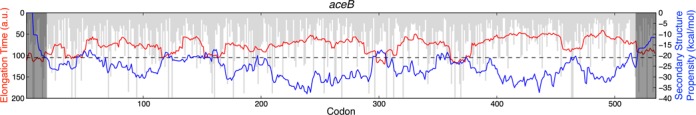
Elongation speed and secondary structure propensity are anti-correlated as exemplified by the aceB gene in Escherichia coli. Codon elongation times are calculated using the method of Zhang et al. (4). Light gray vertical bars represent the individual codon elongations times and the red line the smoothed translational profile. Dips correspond to regions of slow translation. The dotted horizontal line represents a threshold under which translational pausing is thought to occur (4). mRNA secondary structure predicted using Vienna RNAFold is shown by the blue line. Lower values correspond to stronger secondary structure. The first and last 17 codons are removed from our analysis (dark shaded regions).